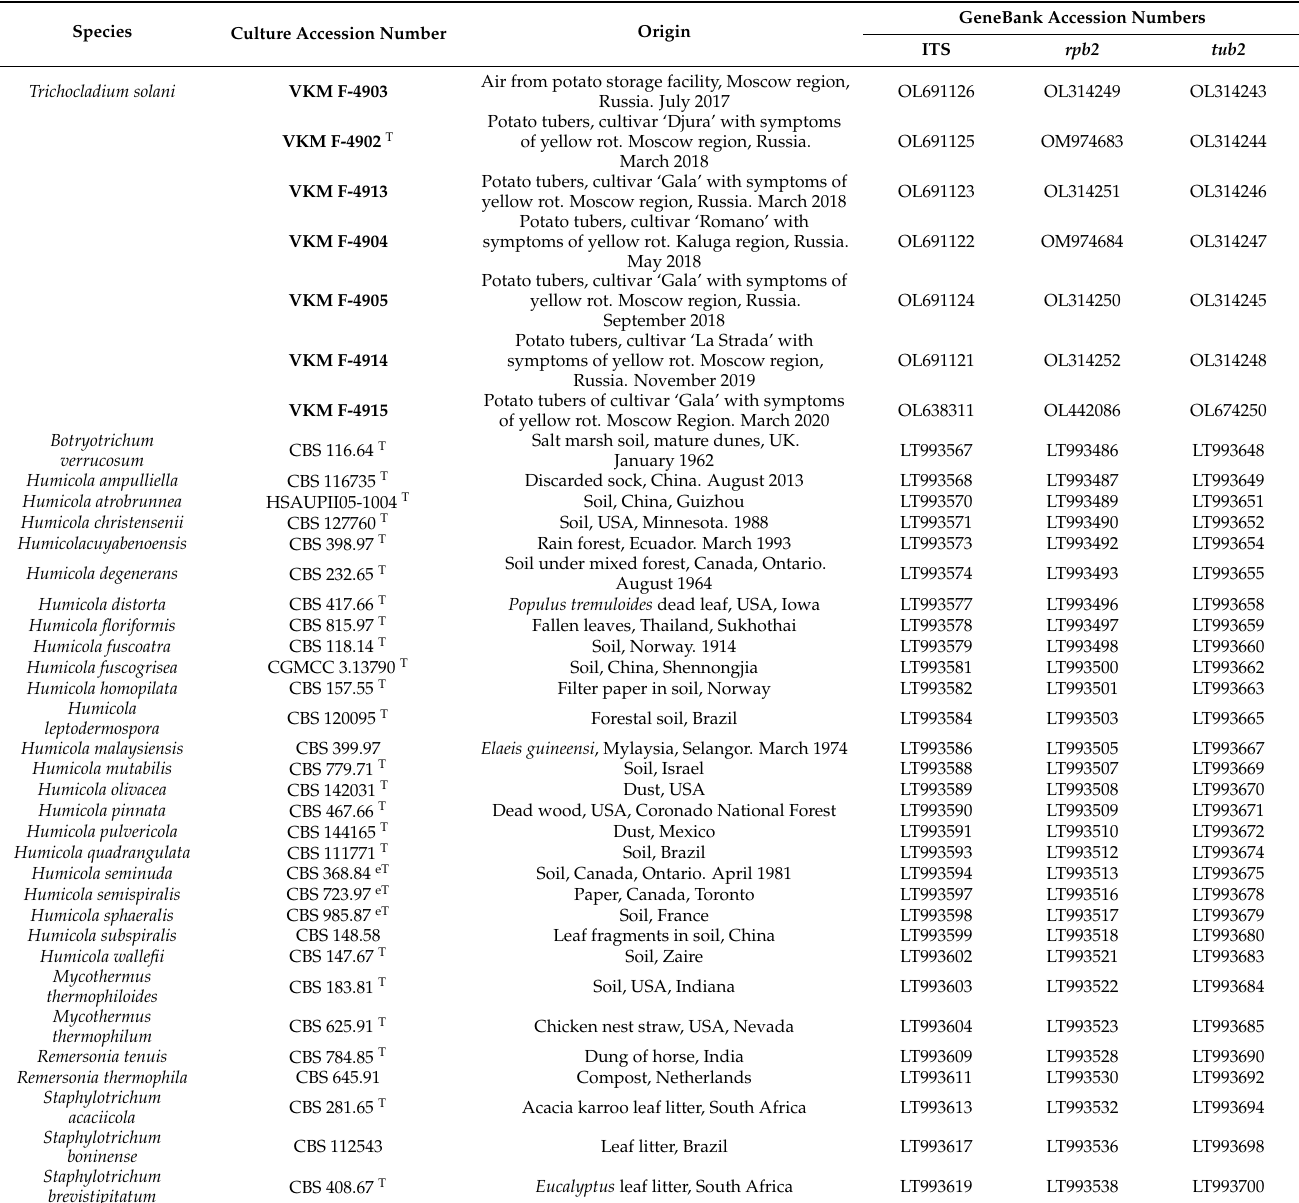
Table 1. Details of strains included in the study. Strains isolated in the study are formatted with bold font. T —type material; eT